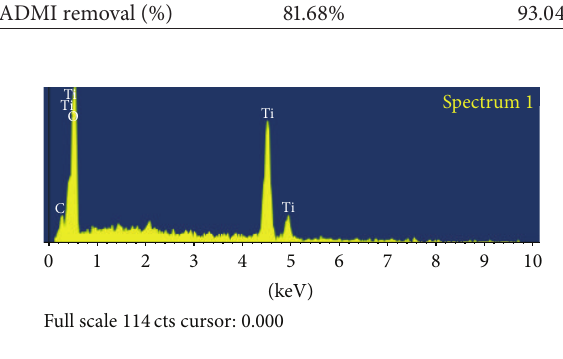
Figure 5: EDX of self-prepared photocatalyst of TiO 2 .